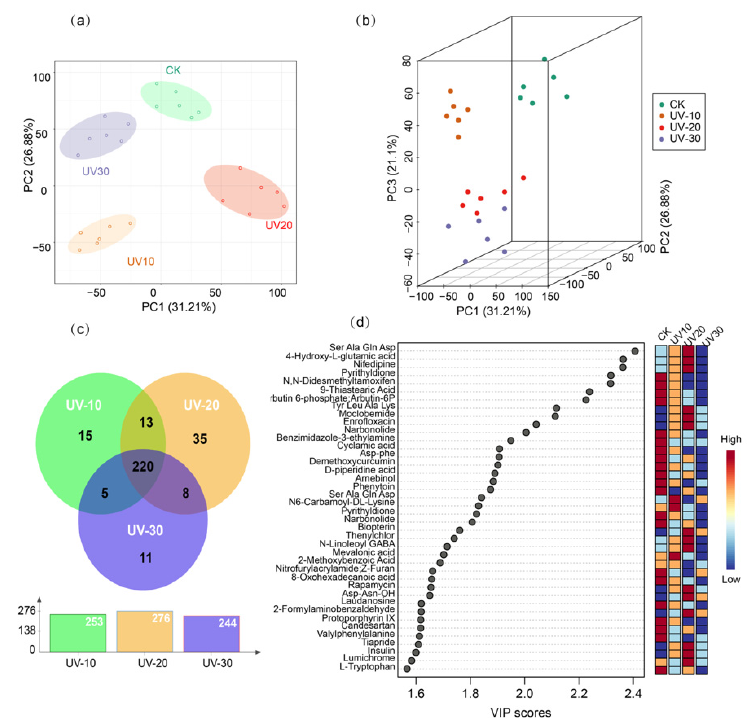
Figure 3. Multivariate analysis of UV-induced metabolites of BSF at different times: ( a ) 2D PCA scores (R 2 Y = 0.736, Q 2 = 0.472), ( b ) PLS-DA 3D scores (R 2 Y = 0.935, Q 2 = 0.73), ( c ) Venn diagram of differential metabolites between the treatment and control groups at different UV induction times (UV 10 min VS CK, UV 20 min VS CK, UV 30 min VS CK), and ( d ) specific differential metabolites between experimental and control groups and their VIP values. Table 1. Bioactive compounds screened from the significant components from different UV-induced treatments of BSF.